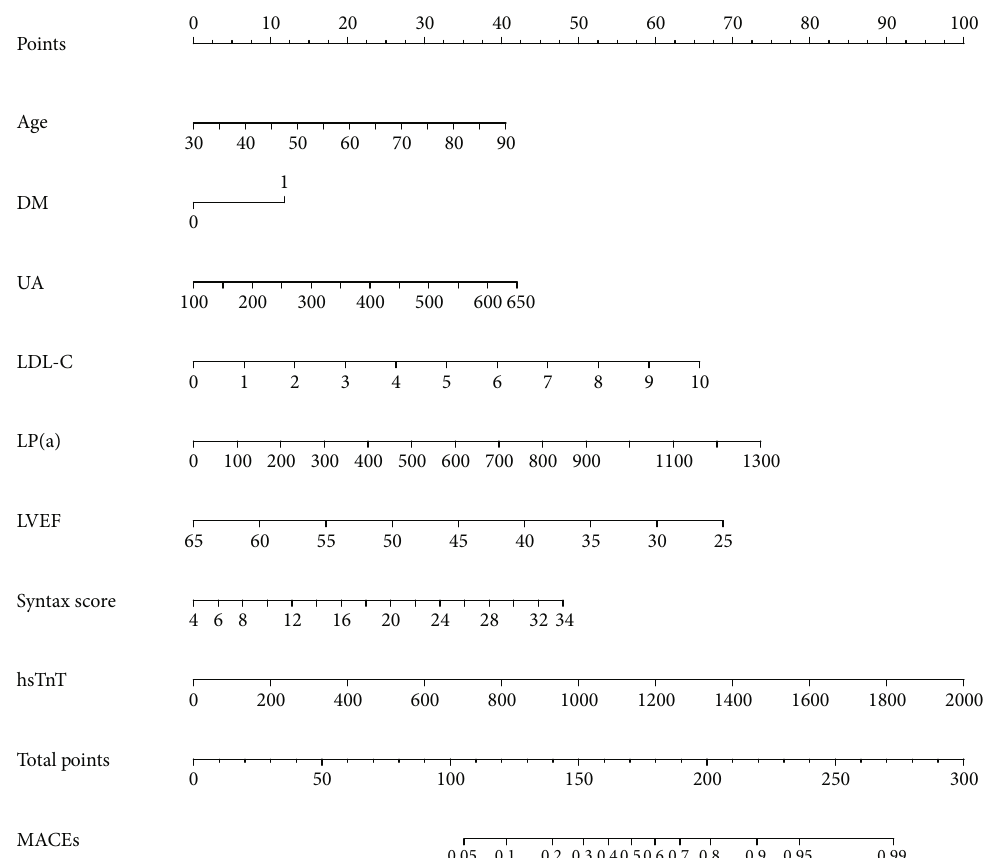
Figure 1: The visible nomogram for predicting 1-year occurrence of MACEs among AMI patients who had PCI. Abbreviations: MACEs: major adverse cardiovascular events; PCI: percutaneous transluminal coronary intervention; AMI: acute myocardial infarction; DM: diabetes mellitus; UA: uric acid; LDL-C: low-density lipoprotein-cholesterol; LP(a): lipoprotein (a); LVEF: left ventricular ejection fraction; hsTnT: hypersensitive troponin